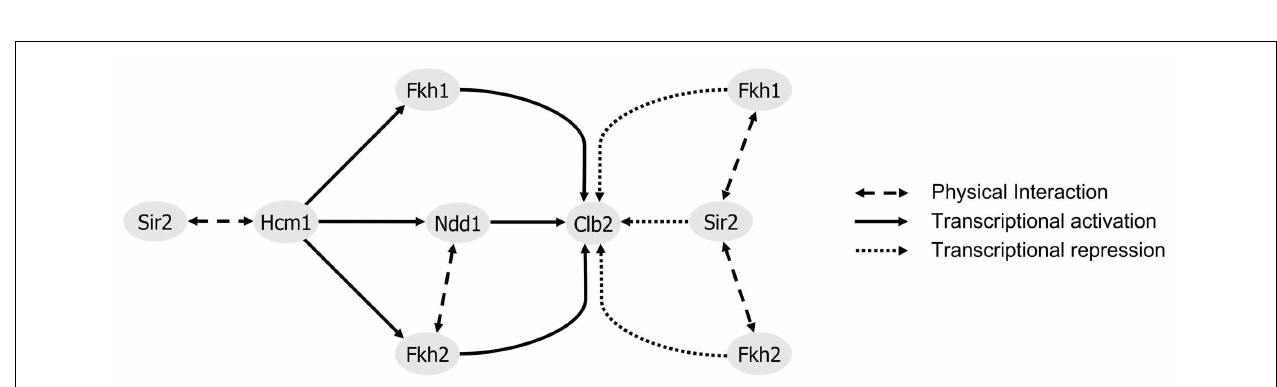
in presence of H 2 O 2 . Yeast cells transformed with plasmids p423GAL-Clb2 or p423GAL were incubated in SC medium containing 2% galactose with or without 2mM H 2 O 2 for 12h. Yeast cultures were then spotted in 1:5 serial dilutions on glucose- or galactose-containing plates, and growth was analysed after 3 days. One representative experiment is shown.